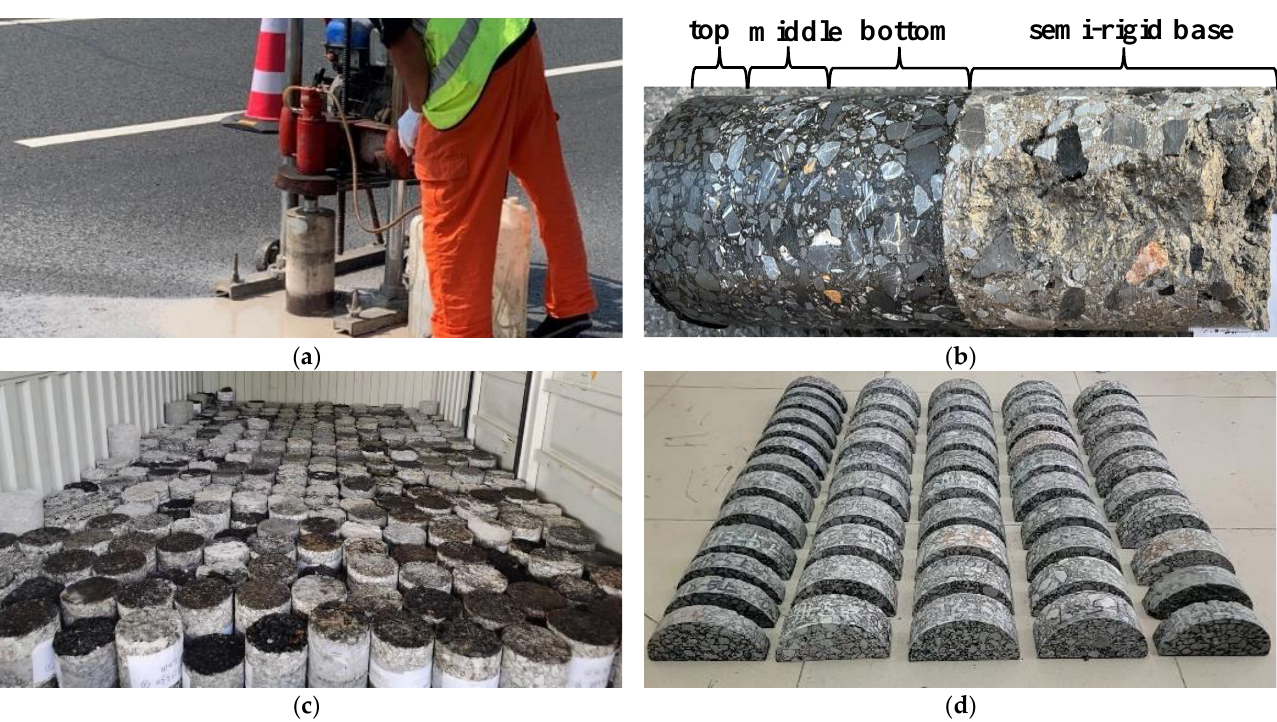
Figure 2. ( a ) Coring procedure; ( b ) A typical field core with three asphalt layers and a semi-rigid base; ( c ) Field cores; ( d ) Semi-circular specimens.